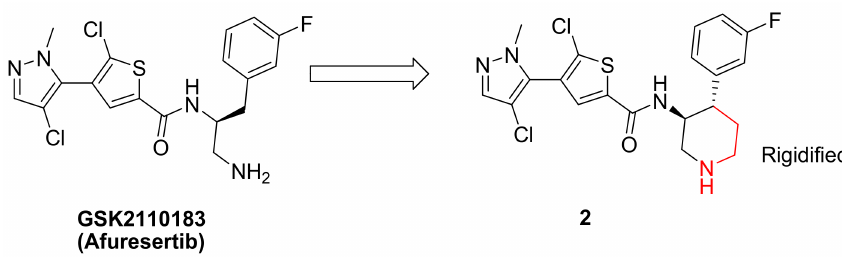
Figure 5. Structures of G-SK2110183 and the rigidification site to yield compound 2 .